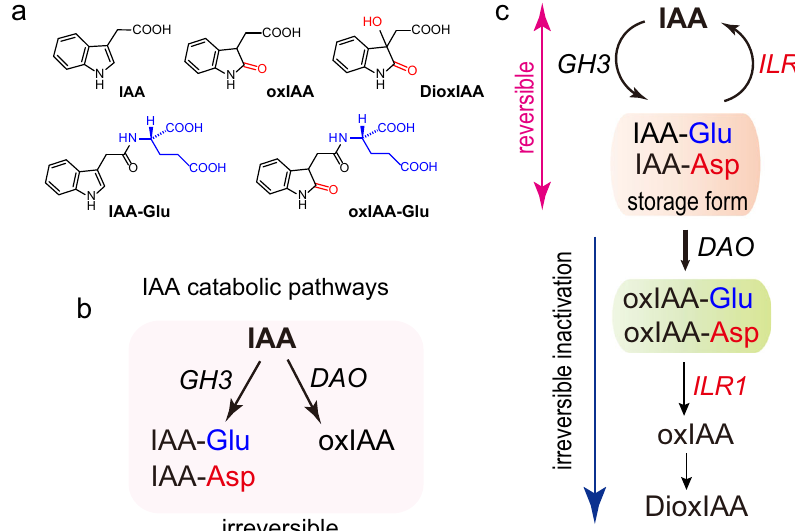
Fig. 1 Structures of IAA metabolites and IAA inactivation pathways. a Structures of IAA metabolites. b The previous model of IAA catabolic pathways. GH3 and DAO irreversibly inactivate IAA through different pathways. c The new model proposed here: the reversible IAA inactivation pathway composed of GH3, ILR1, and DAO1 in Arabidopsis